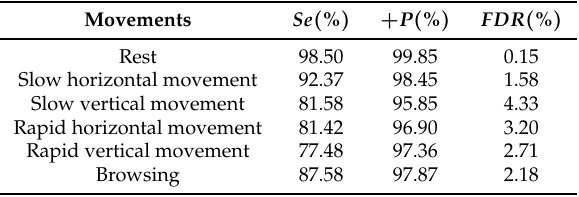
Table 6. Results of sensitivity, positive predictivity, and failed detection rate of all experiment stages of all subjects by the average method.